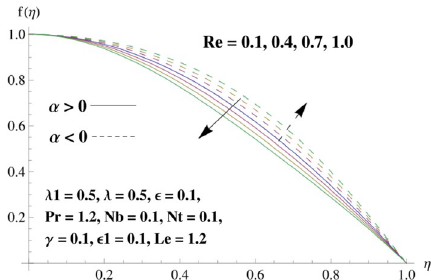
Figure 5. Behavior of f (η) against Re